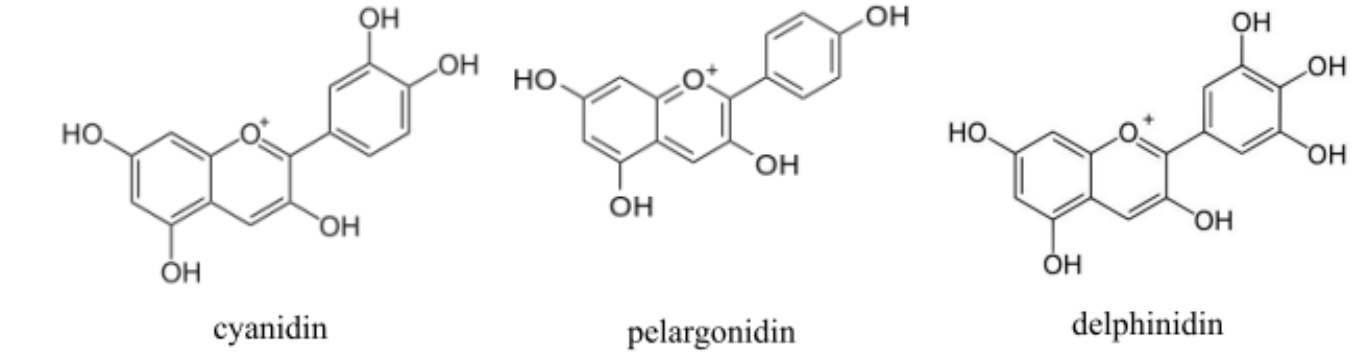
Figure 1. Chemical structures of main anthocyanins’ aglycons.